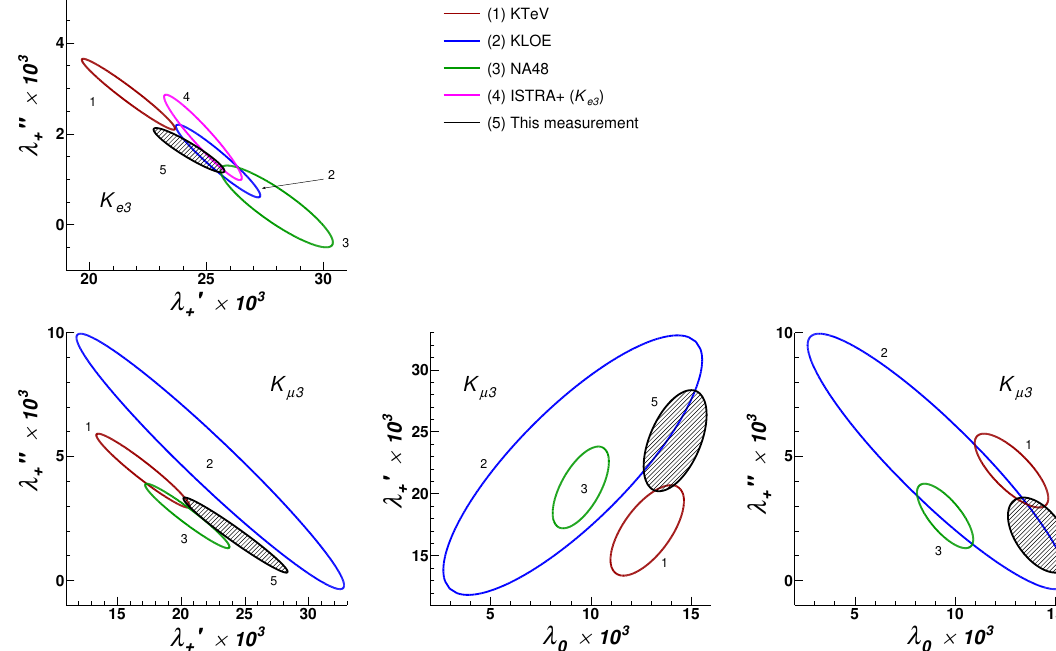
Figure 8 . One sigma (39.4% CL) contours for the obtained parameters of the Taylor expansion of the K e 3 and K (cid:22) 3 FFs together with measurements (obtained from K 0 KTeV [16], KLOE [17, 18], NA48 [19, 20], and ISTRA+ [21, 22] Collaborations. The K e 3 results from NA48 and ISTRA+ have been modi(cid:12)ed by [2] to comply with the considered parameterization. The K (cid:22) 3 results from ISTRA+ do not provide enough information to be displayed on the same panels as the other experimental results.